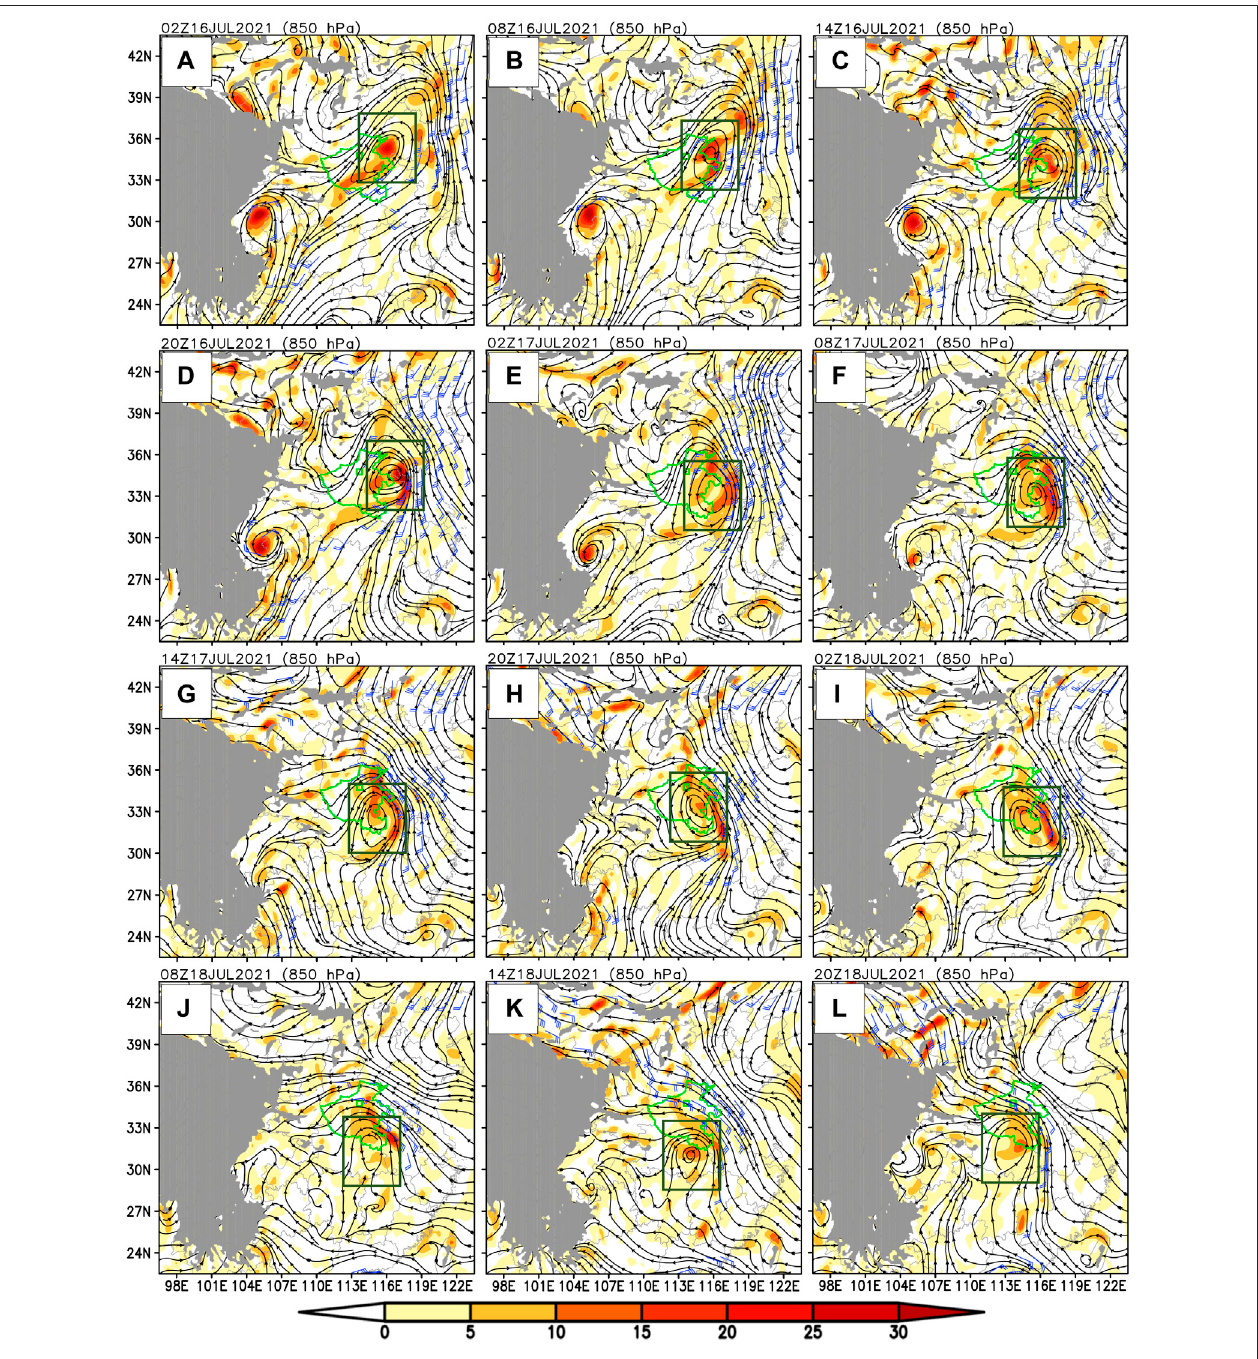
FIGURE 4 | Stream fi eld (black lines with arrows), relative vorticity (shading, 10 − 5 s − 1 ), and wind with speed above 8 m s − 1 (a full bar represents 4 m s − 1 ), where gray shading shows terrain above 1,500 m, green map shows the Henan Province, small green box marks the location of Zhengzhou, and the box green boxes outline the main body of the vortex.